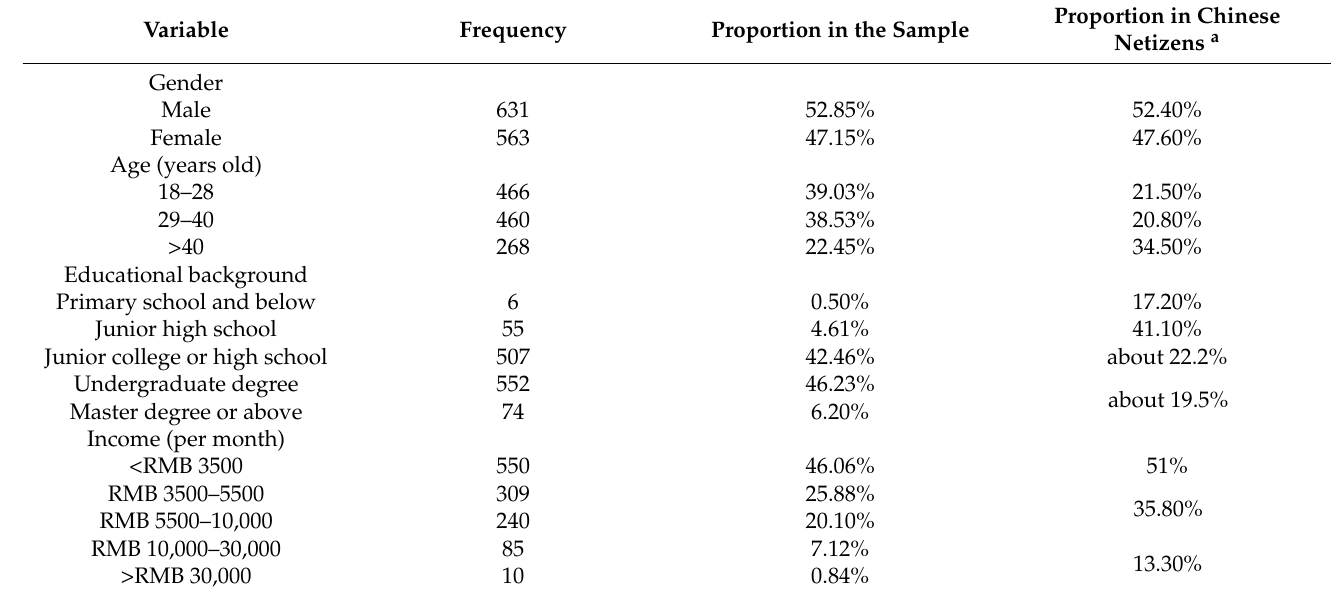
Table 1. Demographic characteristics of the